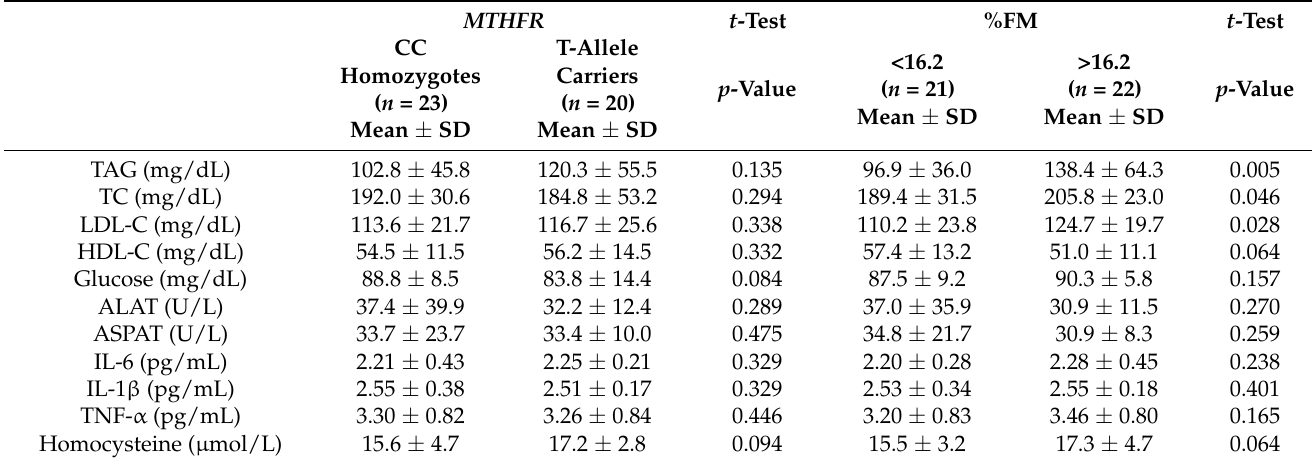
Table 2. Baseline concentrations for blood lipids, glucose, cytokines, homocysteine, and liver enzymes per MTHFR genotype and fat